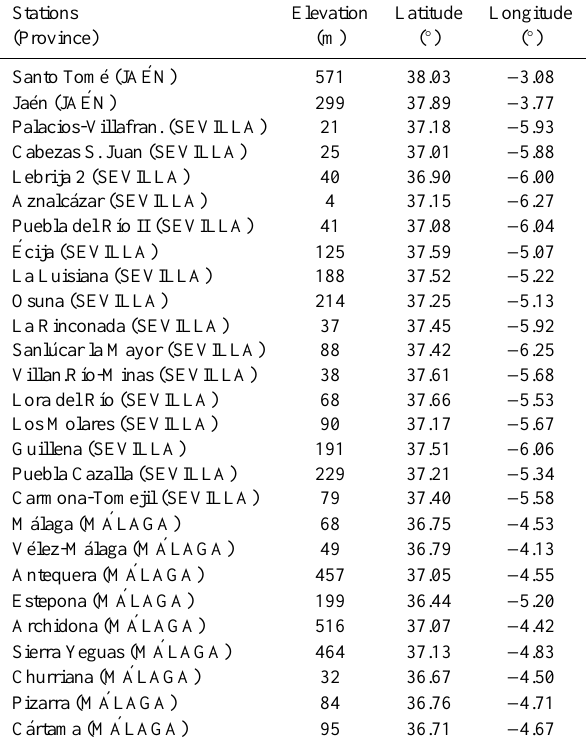
Table 1. Summary of automated weather stations used in the